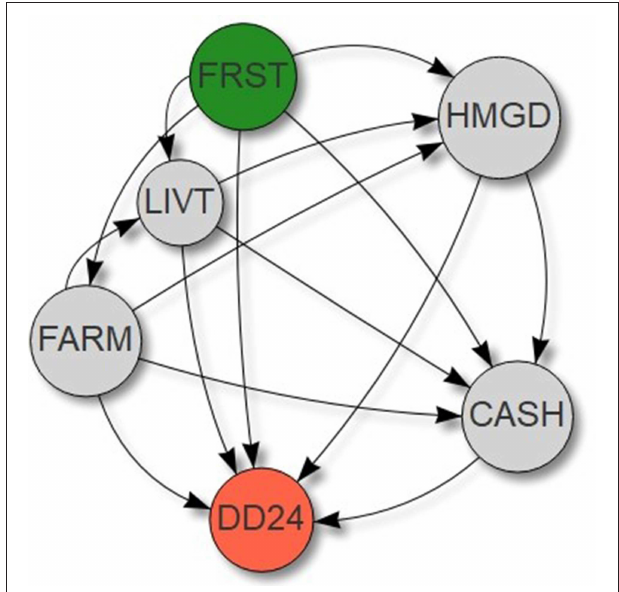
FIGURE 3 | Construct models used to test and quantify the pathways from Figure 1 using piece-wise structural equation modeling. FRST: percentage of forest in a 2-km radius surrounding each household, DD24: household dietary diversity score recorded over the past 24h, FARM: farm size (ha), HMGD: presence/absence of a home garden, LIVT: livestock ownership (TLU), CASH: integration to the cash economy (yes/no). See text for detailed description of the interactions included in this model. The same model was used with the other dietary measures: consumption of fruits in the past 24h (yes/no), consumption of vegetables in the past 24h, and consumption of meat and other animal product (excluding milk and milk products) in the past 24h.